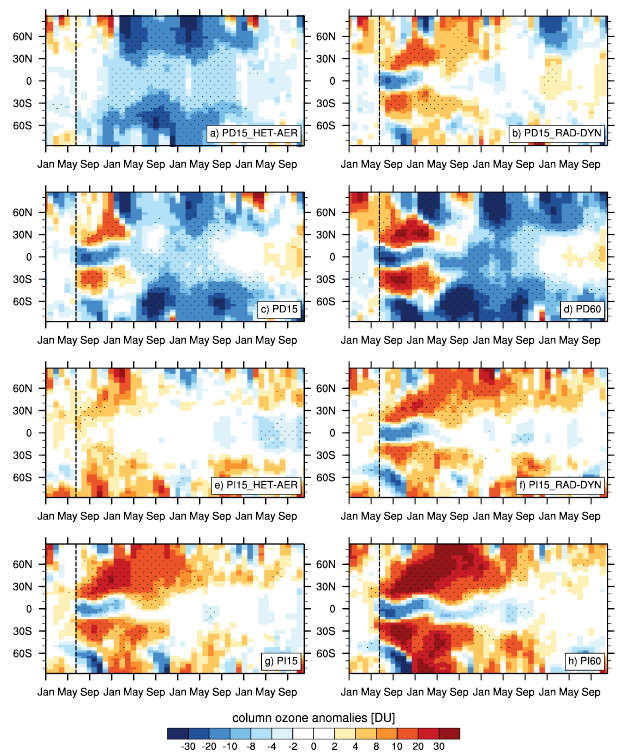
Figure 3. Zonal average monthly mean anomalies of total column ozone in different ensemble simulations: (a) anomalies due to the effect of heterogeneous chemical reactions for the 15Tg eruption for present-day conditions. (b) Same as (a) , but for the radiative- dynamical effects of the aerosols. (c) Same as (a) , but for the full forcing simulations. (d) Full forcing simulations for the 60Tg aerosol forcing data set. (e–h) Similar to (a–d) , but for preindustrial conditions. Stippling in the simulation panels indicates significant differences to the control (Student’s t test p ≤ 0 . 05). The beginning of the eruption is depicted by the vertical dashed line.